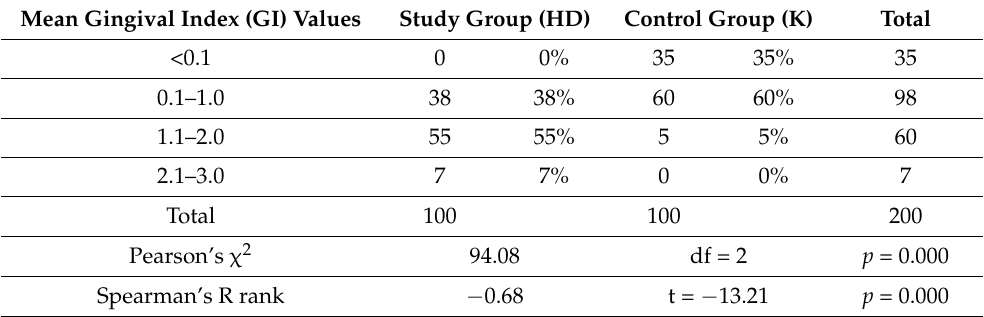
Table 7. Frequency of gingivitis according to Gingival Index (GI) by Löe and Silness in the examined groups (HD, K).